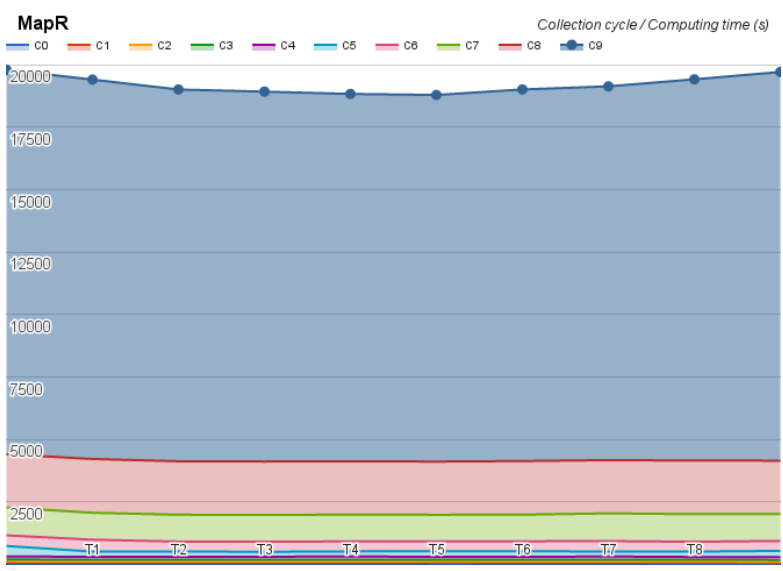
Figure 6. MapR benchmark time (seconds) distribution. Table 2. Apache Hadoop benchmark results